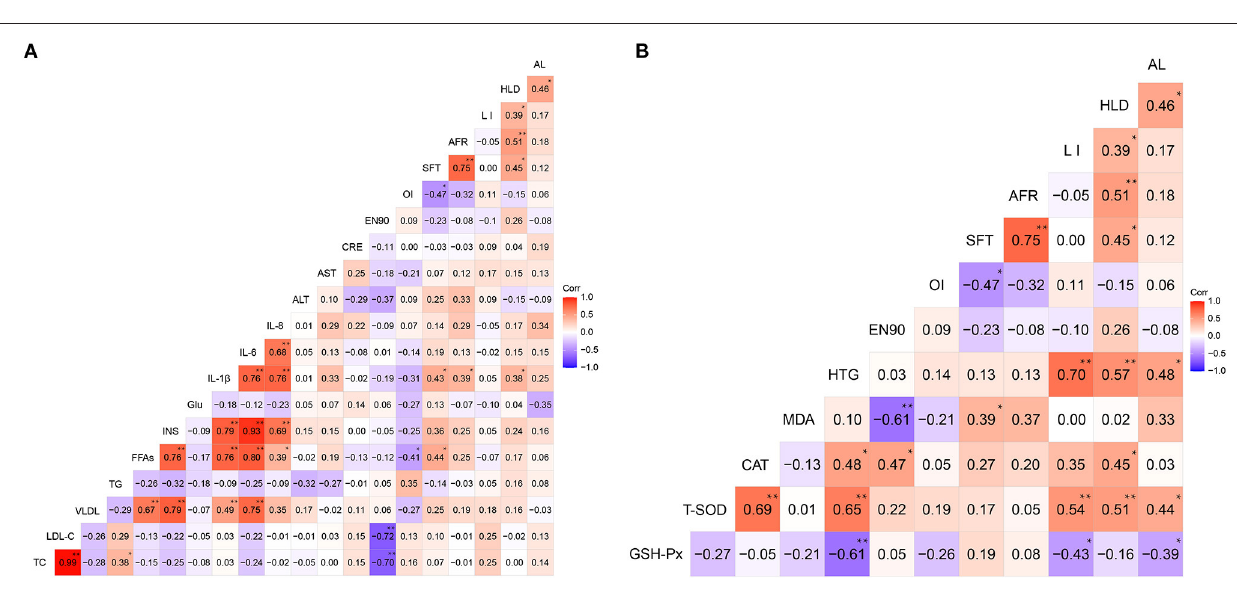
FIGURE 6 | Heat map based on Pearson’s correlations for the relationships among metabolic indices and phenotypic traits (fat deposition characteristics in the aorta, liver, subcutis, and abdomen, organ indices, and production performance) of the 27 selected hens at 90 weeks. (A) Correlations between plasma metabolic indices and phenotypic traits. (B) Correlations between hepatic metabolic indices and phenotypic traits. The color scale represents Pearson’s correlation coefficients, with red and bluish violet representing positive and negative correlations, respectively. Ranging from 1.0 (maximum positive correlation) to − 1.0 (maximum anti-correlation), with 0 indicating no correlation. TC, total cholesterol; LDL-C, low-density lipoprotein cholesterol; VLDL, very low-density lipoprotein; TG, triglyceride; FFAs, free fatty acids; INS, insulin; Glu, glucose; IL-1 β , interleukin-1 β ; IL-6, interleukin-6; IL-8, interleukin-8; ALT, alanine aminotransferase; AST, aspartate aminotransferase; CRE, creatinine; EN90, average number of eggs laid by layers from 19 to 90 weeks; OI, ovarian index; SFT, subcutaneous fat thickness; AFR, abdominal fat rate; LI, liver index; HLD,